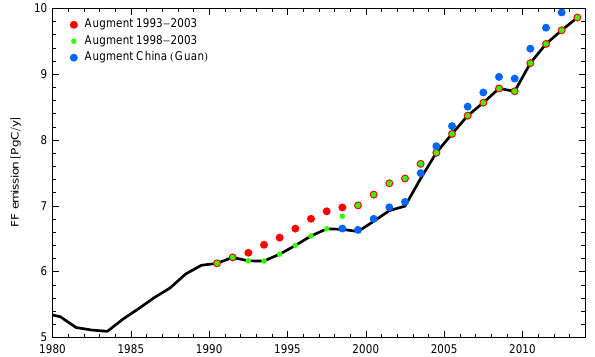
Figure D1. Alternative trajectories for global CO 2 emissions from fossil fuels and other industrial sources ( f Foss ): (black) primary data, (red dots) f Foss augmented by 3% from 1993 to 1998 and 6% between 1999 and 2003 (with tapering), (green dots) f Foss aug- mented by 6% between 1998 and 2003 (with tapering), and (blue dots) f Foss if recent Chinese emissions are revised upward to use summed provincial rather than national data (Guan et al., 2012) (their Fig. 2). The trajectories shown by red and green dots follow suggestions of global emissions underestimates in the 1990s to early 2000s (Francey et al.,